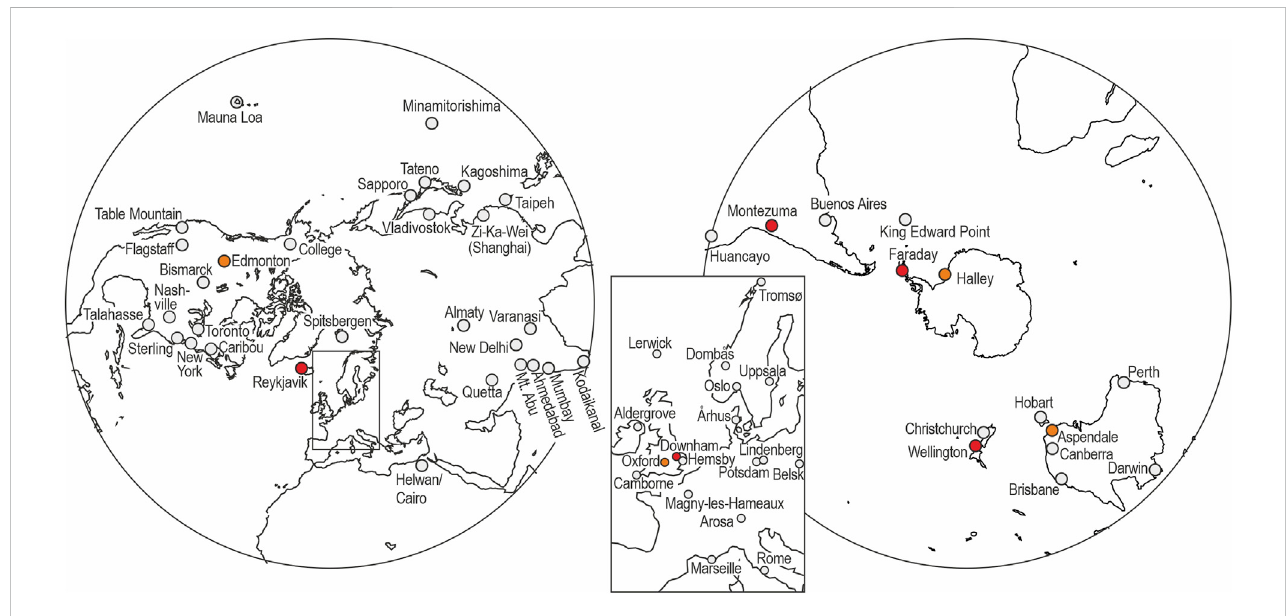
FIGURE 1 Map of series (grey: used in HISTOZ, red: new series, and orange: supplemented series).